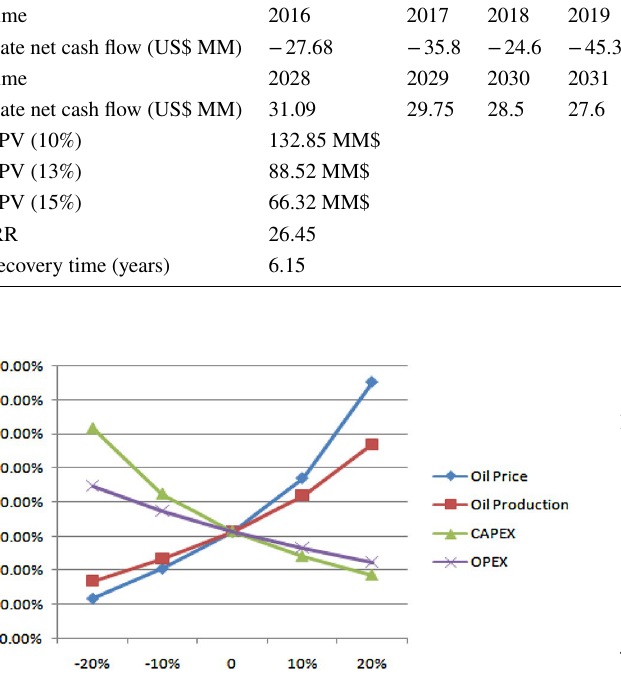
Fig. 17 IRR sensitivity analysis